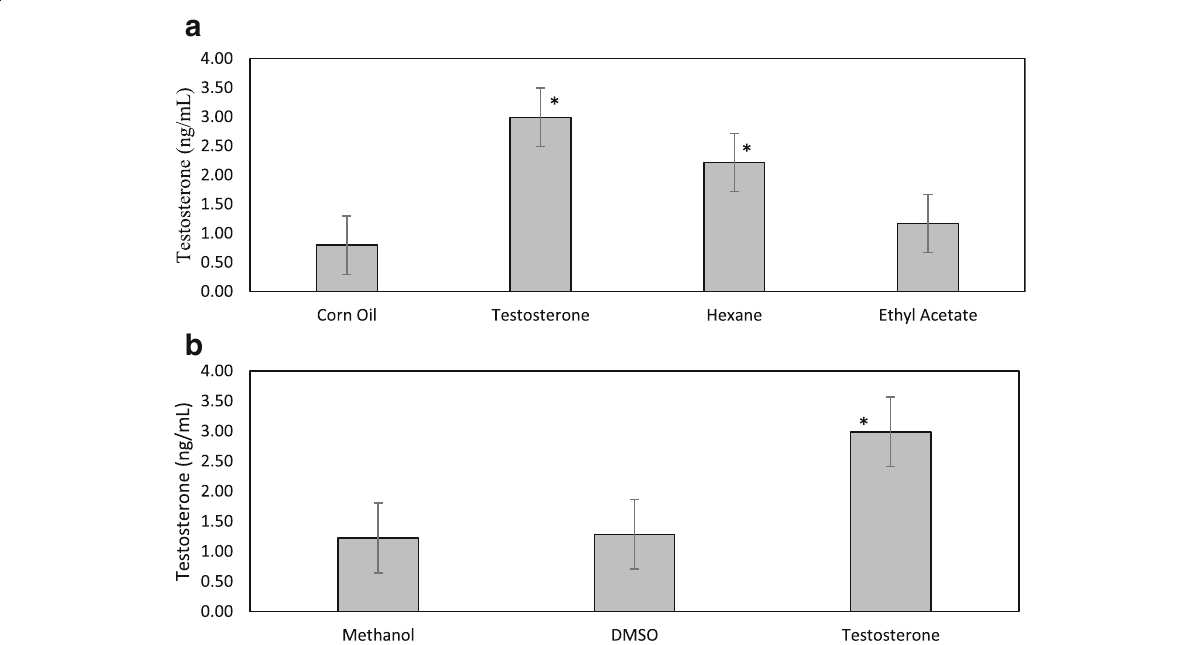
Fig. 6 a The effects of the hexane and the ethyl acetate crude extracts from D. canum on the serum testosterone levels in normal Sprague- Dawley rats. *Indicates significant difference when compared with the corn oil control, p < 0.05. b The effect of the methanol crude extract from D. canum on the serum testosterone level in normal Sprague-Dawley rats. *Indicates significant difference when compared with the control, p <